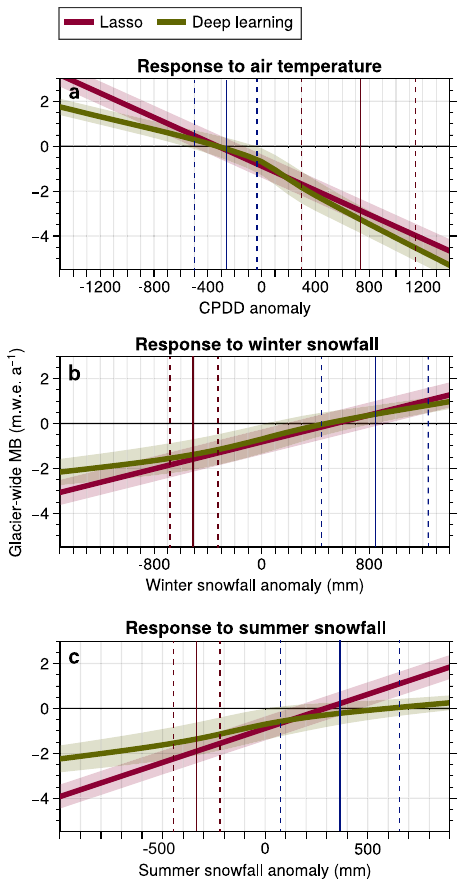
Fig. 3 Nonlinear and linear response to climatic forcing of MB models. Nonlinear deep learning response and linear Lasso response to a Cumulative positive degree days (CPDD) anomalies, b winter snowfall, and c summer snowfall. All climate anomalies are computed with respect to the 1967 – 2015 mean values. Envelopes indicate ± σ based on results for all 660 glaciers in the French Alps for the 1967 – 2015 period. The vertical blue and red lines indicate the distribution of extreme (top 5%) values for all 21st century projected climate scenarios, with the mean value in the center and ±1 σ indicated by dashed